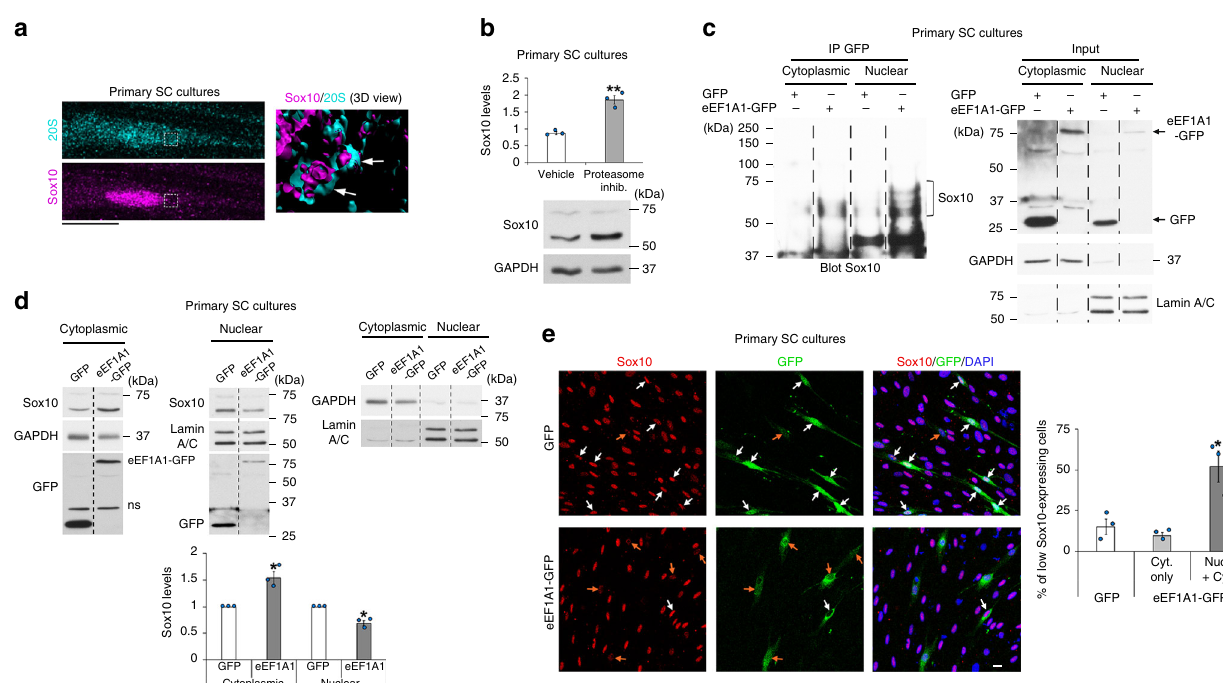
Fig. 3 EEF1A1 re-localizes Sox10 to the cytoplasm and reduces its expression. a Sox10 and 20 S co-immuno fl uorescence in SCs cultured under de- differentiation conditions. Representative images (z-series projections) are shown. The right image is a magni fi ed 3D view of the region highlighted by a dashed box on the left images. Arrows point to proteasome structures containing Sox10. b Sox10 and GAPDH Western blot in lysates of SCs induced to de- differentiate for 1 day and treated with the proteasome inhibitor MG132 (proteasome inhib.) or vehicle (Veh.) for 12 h, and Sox10 quanti fi cation normalized to GAPDH ( n = 3 independent experiments). c GFP immunoprecipitation (IP) and Sox10 Western blot in nuclear and cytoplasmic fractions of SCs transfected with eEF1A1-GFP or GFP and induced to de-differentiate for 1 day, and input GFP, LaminA/C (nuclear fraction) and GAPDH (cytoplasmic fraction) on lysates used for IPs. d Sox10 and GFP Western blots in nuclear and cytoplasmic fractions of SCs transfected with a construct expressing eEF1A1-GFP or control GFP and induced to de-differentiate for 1 day, and Sox10 quanti fi cation (normalized to GAPDH or Lamin A/C) in each fraction. n.s. = non-speci fi c. e Sox10 immuno fl uorescence with GFP fl uorescence and DAPI (nuclei) labeling in SCs expressing eEF1A1-GFP or control GFP and cultured under de-differentiating conditions for 3 days, and % of low Sox10-expressing cells among cells expressing GFP or eEF1A1-GFP in the cytoplasm only (Cyt. only) or in both nucleus and cytoplasm (Nucl. + Cyt.). Arrows point to transfected SCs ( e ). Orange arrows indicate transfected SCs with low Sox10 levels and/or with eEF1A1 localized in the nucleus ( e ). Dashed lines indicate that samples were run on the same gel but not on consecutive lanes. Data are presented as mean values± SEM. Unpaired ( b , e ) or paired ( d ) two-tailed Student ’ s t -tests. P values: 0.001725 ( b ), 0.045156 ( d , cytoplasmic), 0.024327 ( d , nuclear), 0.02473 ( e ). N = 3 independent experiments ( b , d , e ), 15 – 25 (GFP) and 48 – 58 (eEF1A1-GFP) transfected cells counted per n ( e